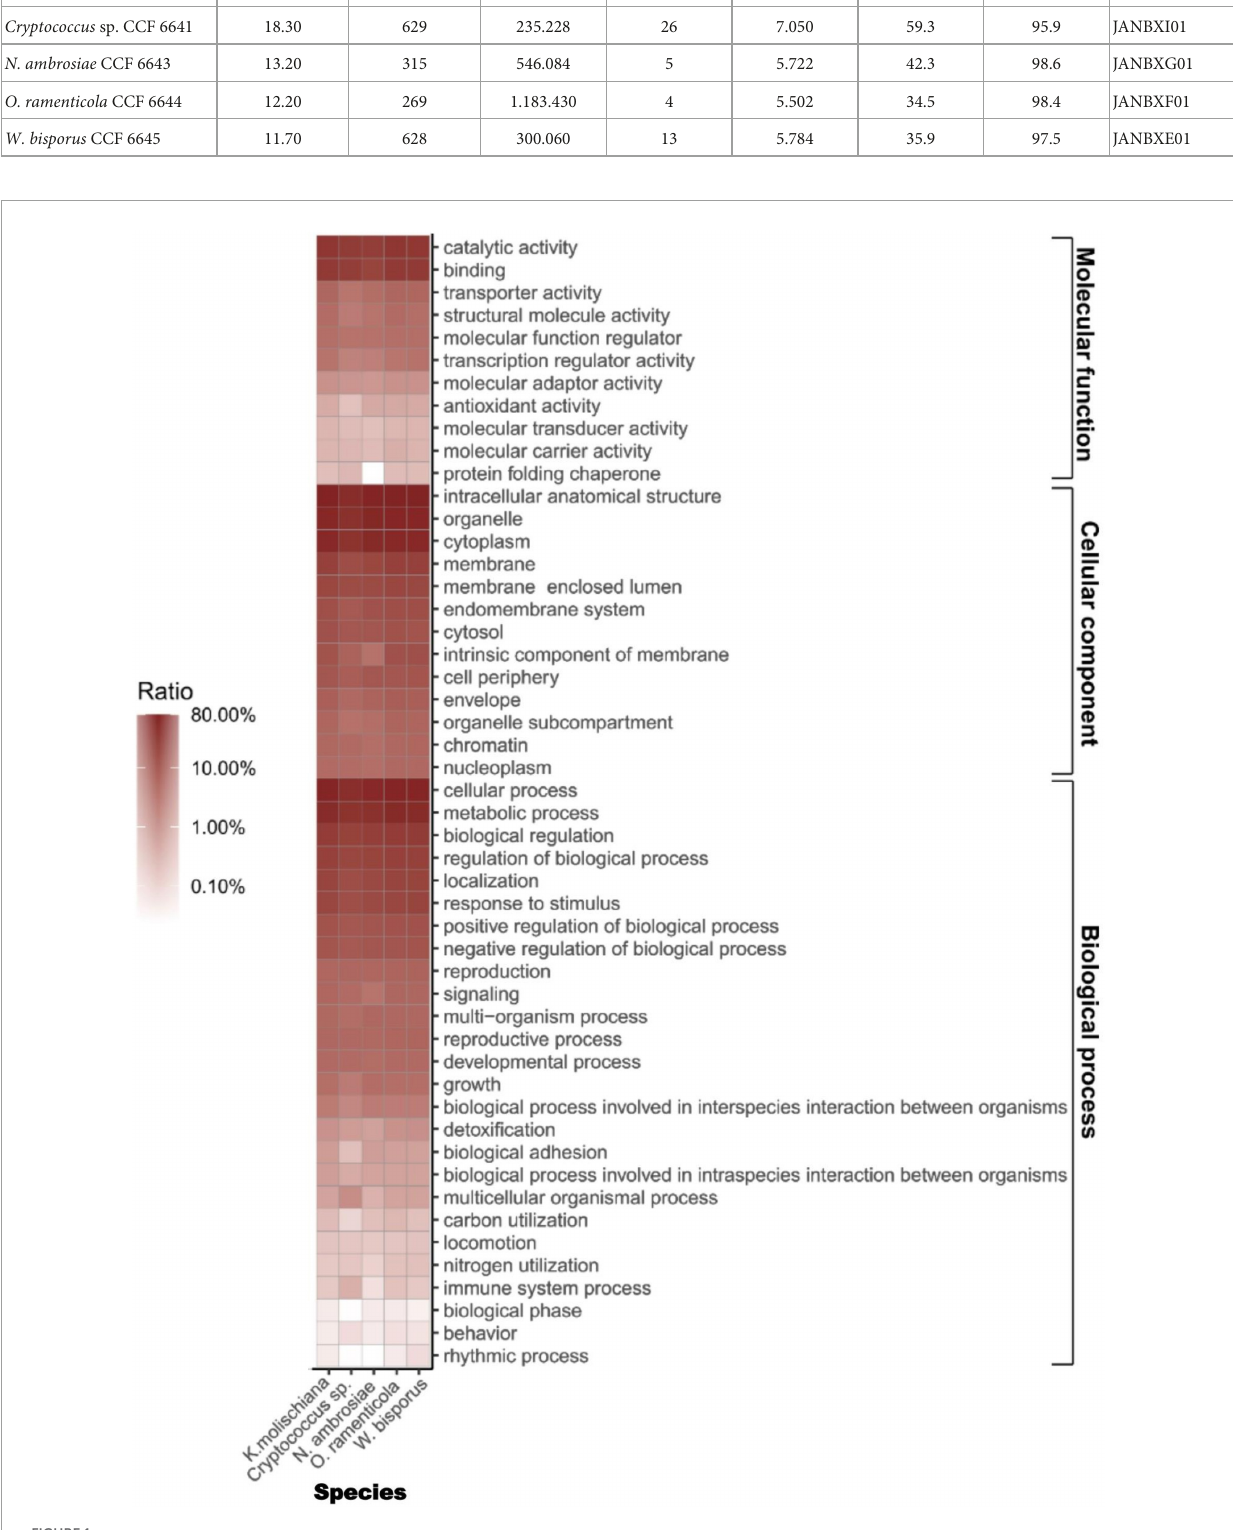
FIGURE1 Gene Ontology (GO) terms enrichment in five genomes. The GO annotation is presented in Y -axis, while species names were labeled in X -axis.